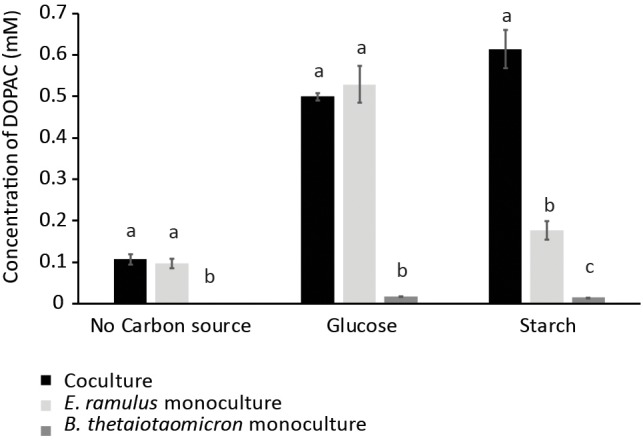
DOPAC concentration as measured by HPLC in cultures with no carbon source, glucose (0.7%), and starch (1%). Culture tubes were inoculated with only B. thetaiotaomicron or E. ramulus or both and incubated for 22 h. Error bars corresponds to 3 replicates. Different letters above bars indicate significant difference between type of culture at p < 0.05 according to Least Significant Difference (LSD).